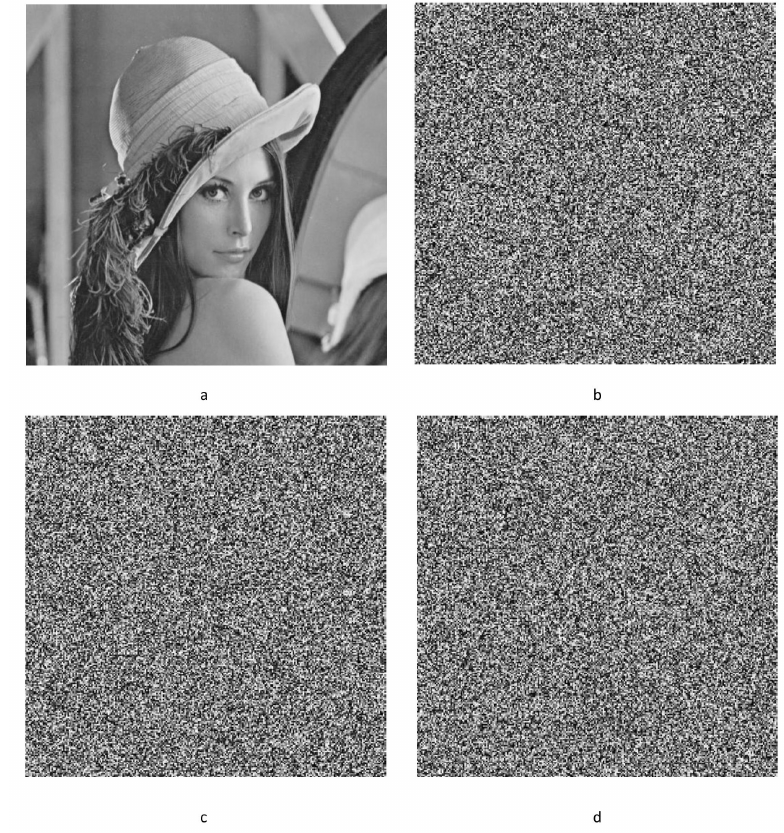
Figure 11. Sensitivity test results of Lena image. ( a ) decrypted image with correct key. ( b – d ) are, respectively, decrypted image adding +10 − 16 to the initial values x 1,1 , x 1,2 , and the parameter α 1 .